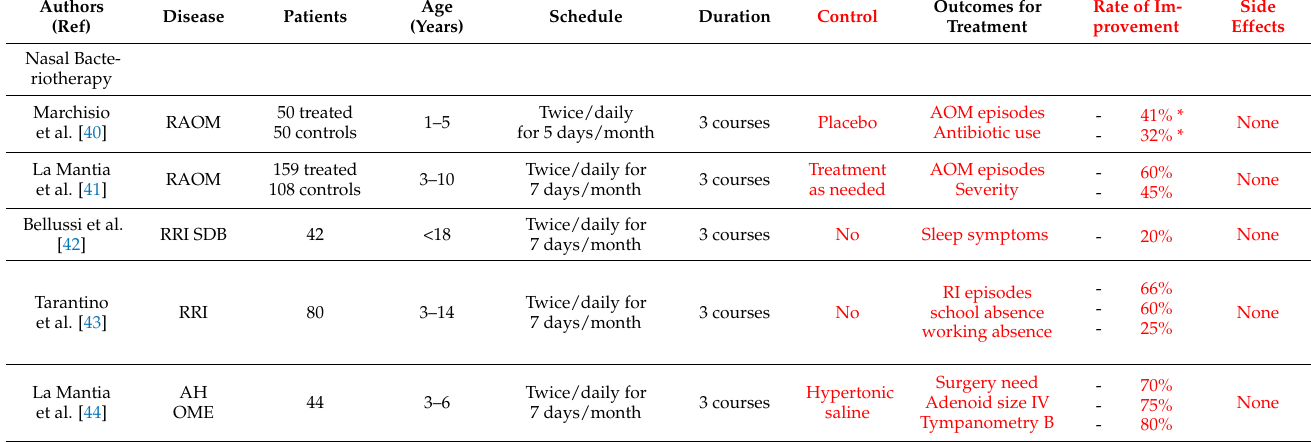
Table 1. Studies that investigated Local Bacteriotherapy when administered as a nasal spray or oral spray (RAOM = recurrent acute otitis media; RRI = recurrent respiratory infection; SDB = sleep- disordered breathing; AH = adenoid hypertrophy; OME = otitis media with effusion; m = median; RPT = recurrent